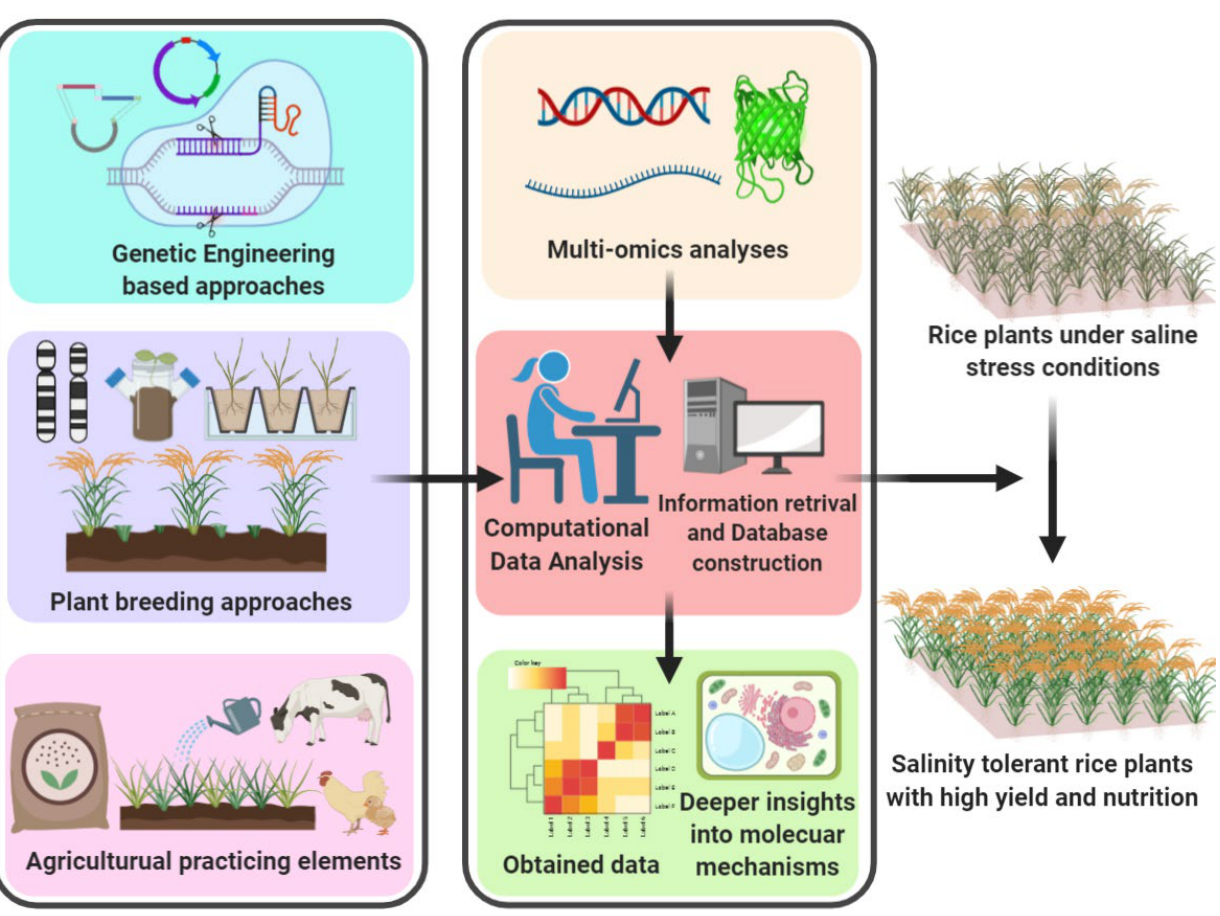
Figure 1. Schematic representation of various biological approaches speculated to develop the salinity tolerant rice plants (the image created in BioRender.com accessed on 02 June 2022).